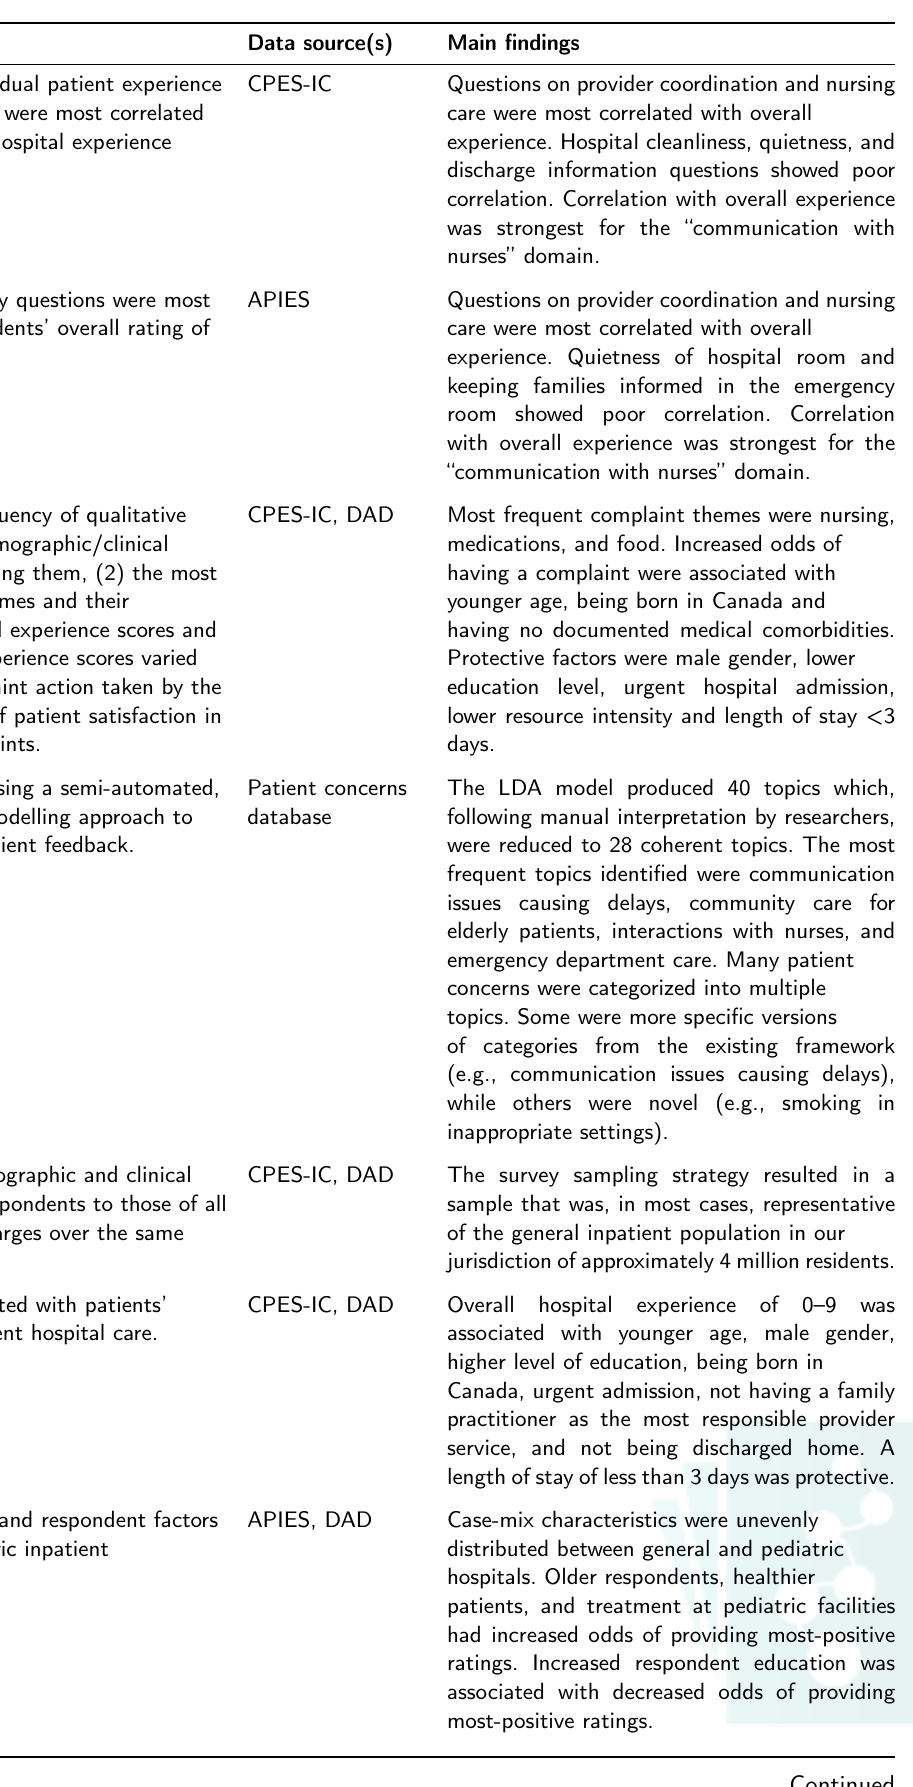
Table 1: Published research using patient experience